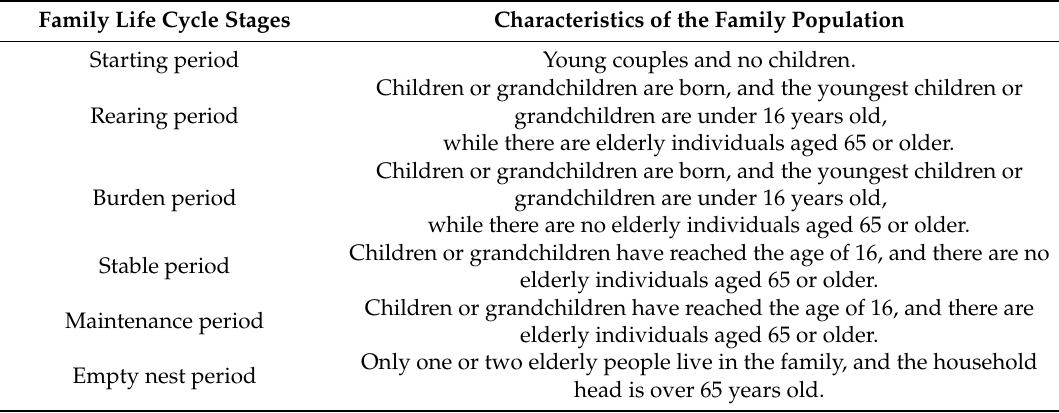
Table 2. Definition of model variables and descriptive statistical